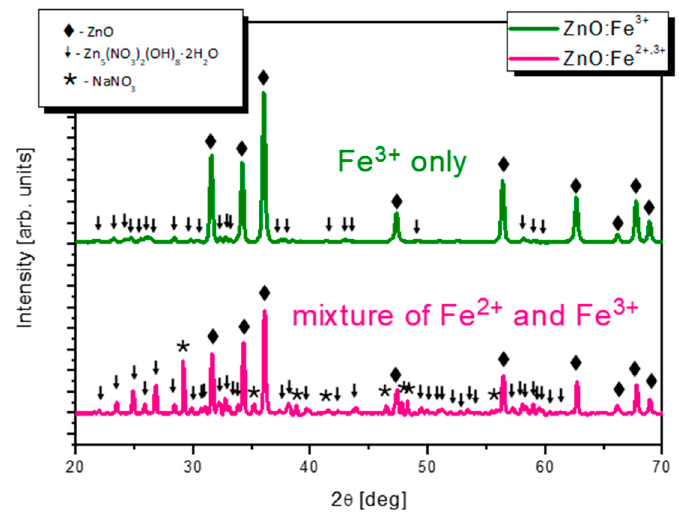
Figure 1. X-ray diffraction patterns of ZnO:Fe 3+ nanoparticles (upper) and ZnO:Fe 3+ enriched with iron 2+ ions (lower pattern). Marked by the patterns: (cid:117) —wurtzite type ZnO phase (PDF no. 79-0208), ↓ —Zn 5 (NO 3 ) 2 (OH) 8 ∙ 2H 2 O (PDF no. 24–1460), —NaNO 3 (PDF no. 36-1474).